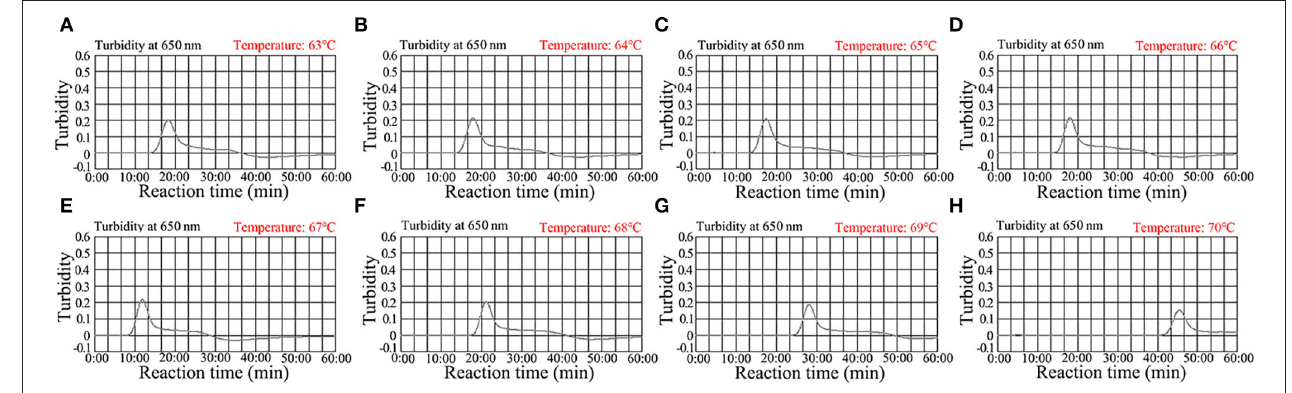
FIGURE 4 | Optimization of the temperature for C. trachomatis -LAMP reactions. C. trachomatis -LAMP reaction process was monitored using real-time turbidity (LA-500). The threshold value was 0.1, and the turbidity > 0.1 was regarded as positive. Eight kinetic graphs (A–H) were yielded at various amplification temperatures